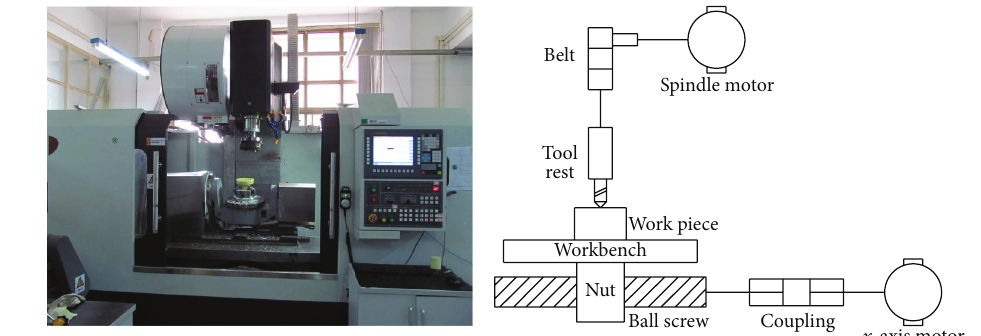
Figure 2: Spindle and 𝑥 -axis system structure diagram of CNC.